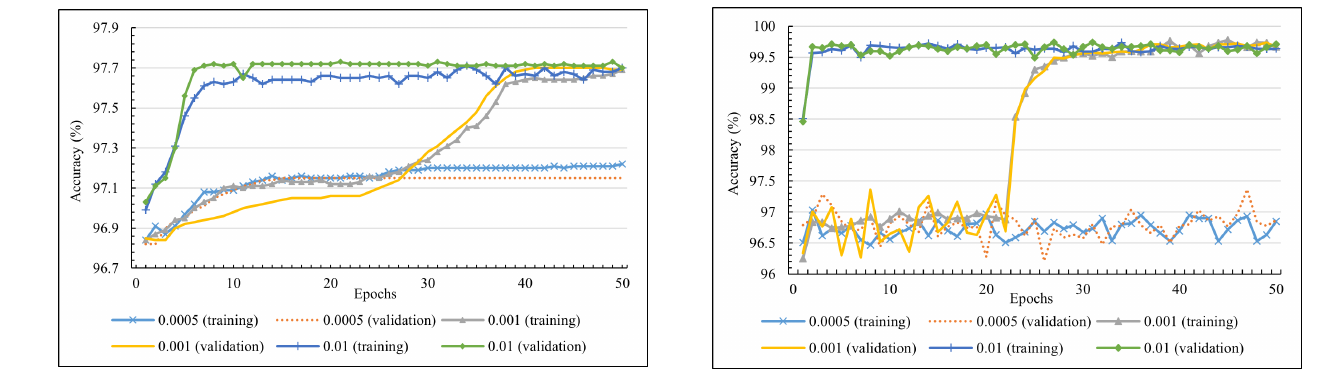
Figure 8. The trained results in fifty epochs with three different learning rates: 0.0005, 0.001, and 0.01 for the PYNQ-Z2 SoC FPGA.